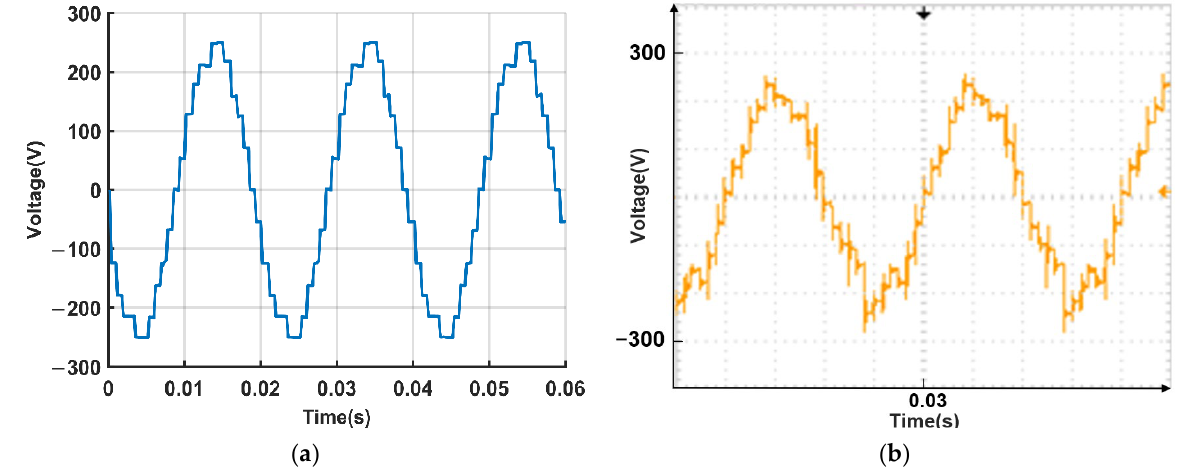
Figure 15. No-load phase-A output voltage diagram of finite element model and experiment. ( a ) FEM waveform; ( b ) experimental waveform.